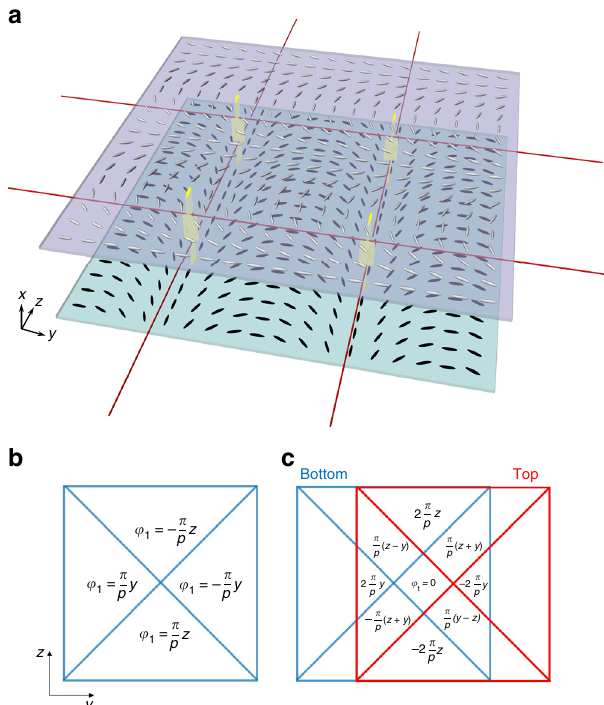
Fig. 5 Director pro fi le in the surface patterned cell in the area of square web of disclinations. a Schematic illustration of square web of disclinations in a nematic LC cell held between the patterned substrates. Periodic arrays of twist disclinations ( red lines ) are generated by the periodic orientational patterns on the top and bottom substrates (the two lines along the y -axis are generated from top surface, while the lines along z -axis are produced by surface alignment from bottom substrate), and are stably located by elastic forces a few micrometers apart from one another at the intersections. The intersections of the disclination lines, highlighted by eye-guiding yellow strips giving the sheets of directors, are anchored where the directors on the bottom and the top surfaces are parallel, whereas the middle points of the line are positioned at the place of ± π /2 twist. b Position dependence of the azimuthal orientation of LC director on the square patterned substrate. Flipping this substrate over to have the top substrate, we see that the azimuthal angle changes its sign irrespective of the manner it is fl ipped, i.e., φ = − φ φ = φ − φ 2 1 . c Position dependence of the twist angle, t 2 1 , in the